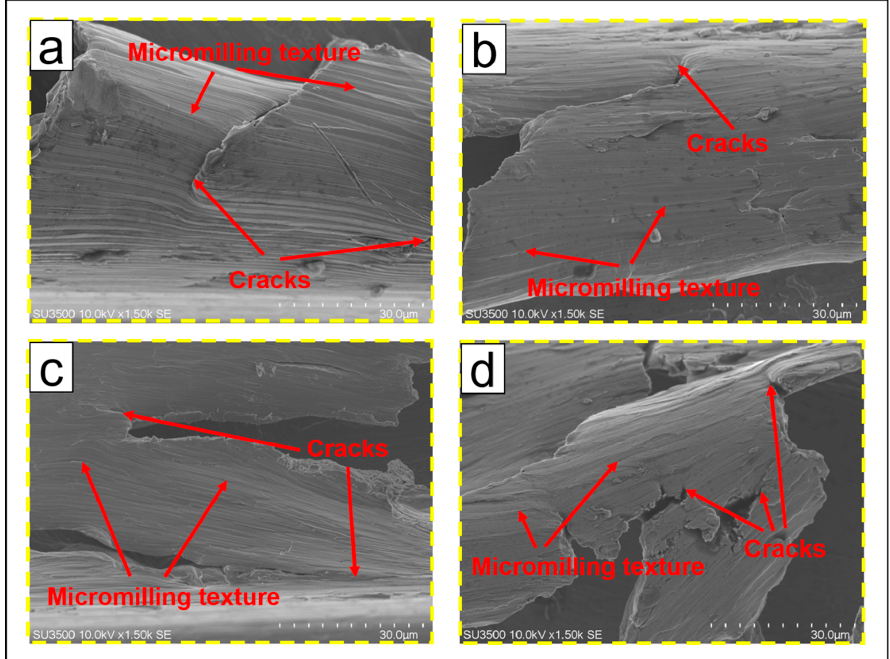
Figure 10. Simulation of burr growth ( a – c ): TMM; ( d – f ): UVAMM.